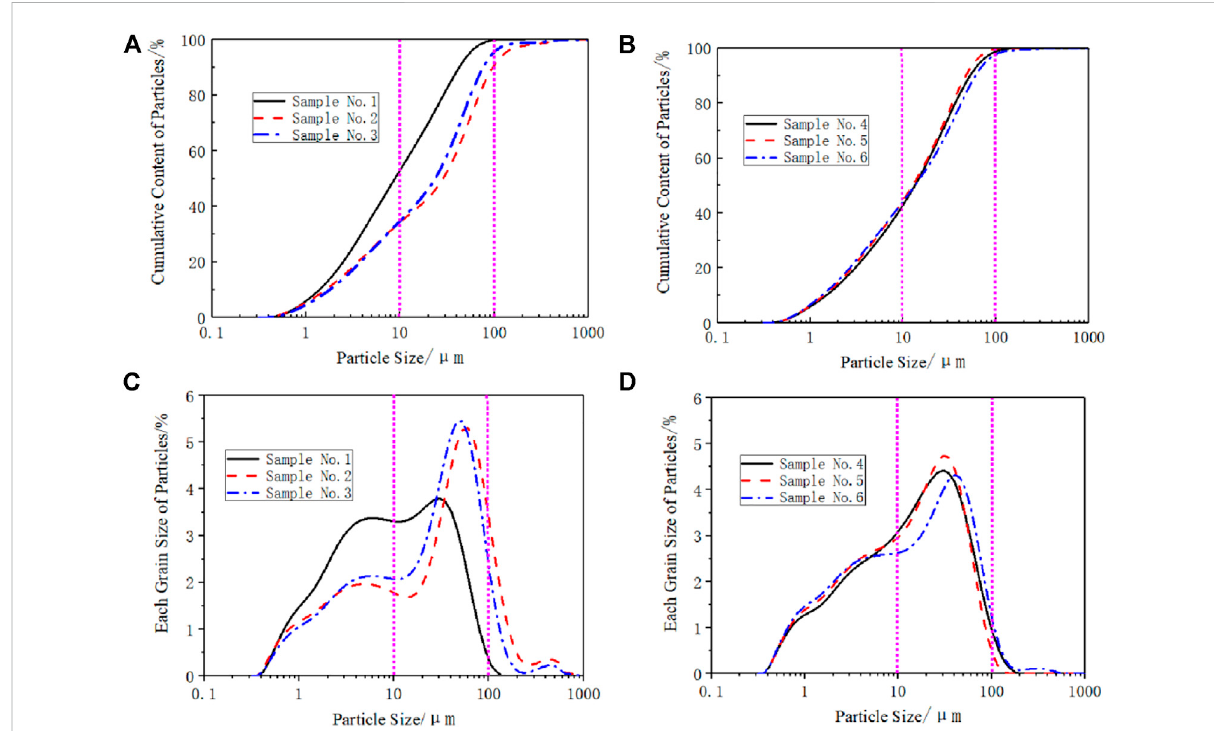
FIGURE 4 (A) Logarithmic curve of the particle size distribution on samples at disease segments, (B) Logarithmic curve of the particle size distribution on samples at non-disease segments, (C) Cumulative logarithmic curve of the particle size distribution on samples at disease segments, and (D) Cumulative logarithmic curve of the particle size distribution on samples at non-disease segments.